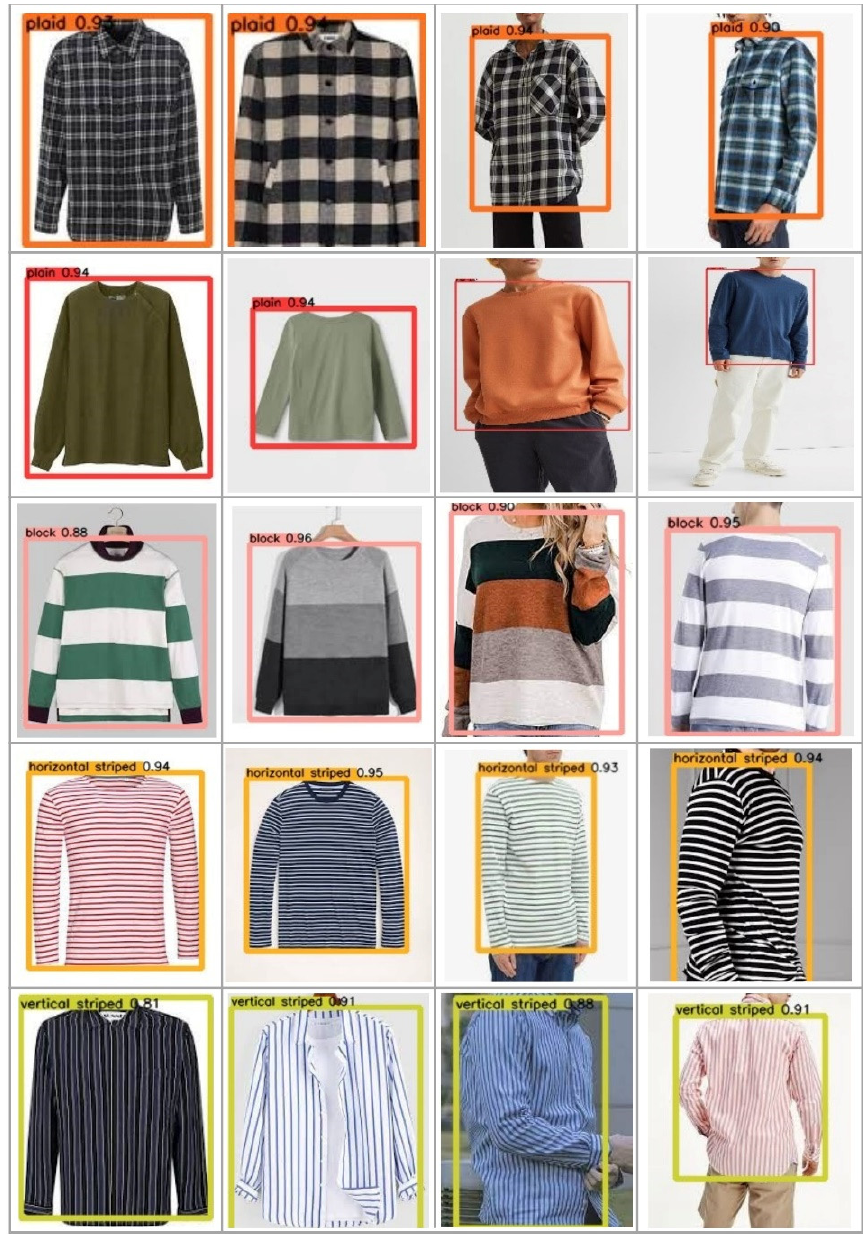
Figure 14. Testing results (top to bottom: plaid, plain, block, horizontal, vertical). Table 2. Performance comparisons of different deep learning